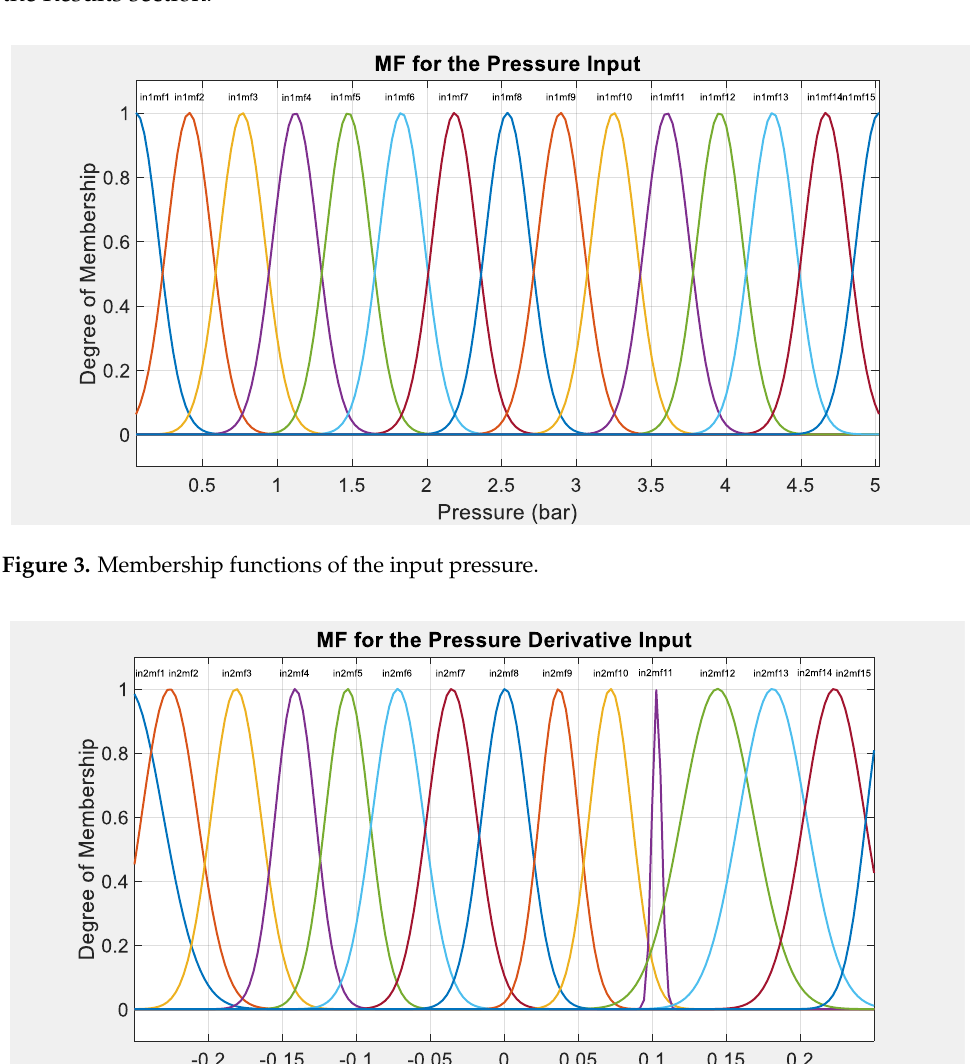
Figure 5. ANFIS multilayer architecture. Figure 6. Rule base surfaces of the ANFIS hysteresis model.